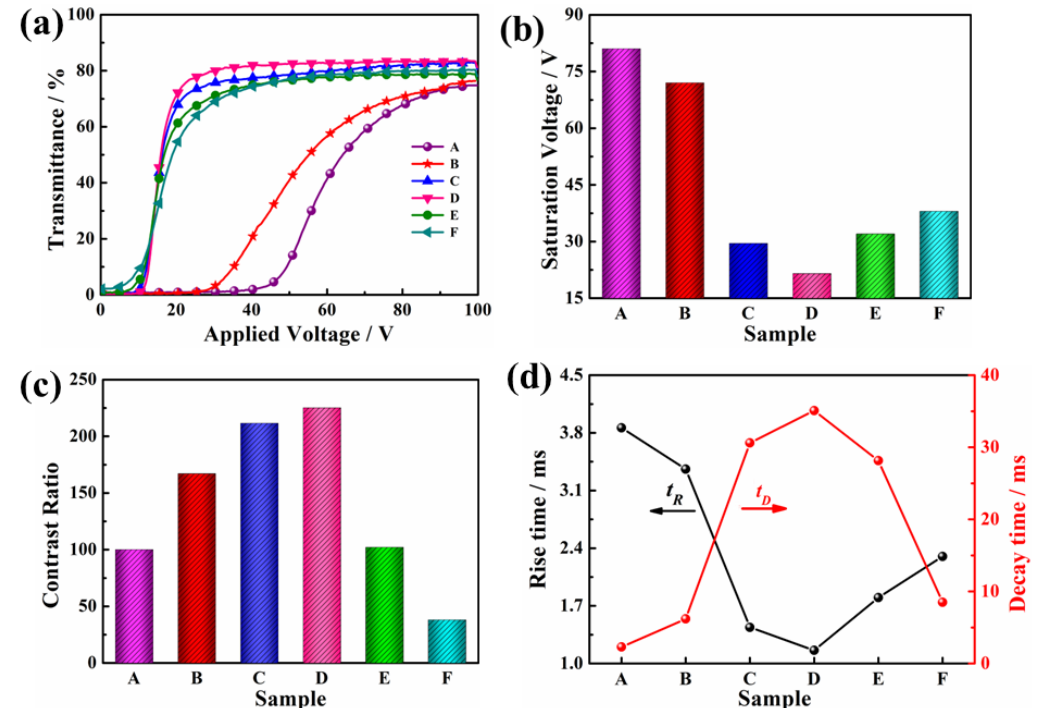
Figure 5. ( a ) The curve of A-F samples transmittance with voltage, ( b ) V sat , ( c ) CR , ( d ) t R and t D of A- E sample. A-E